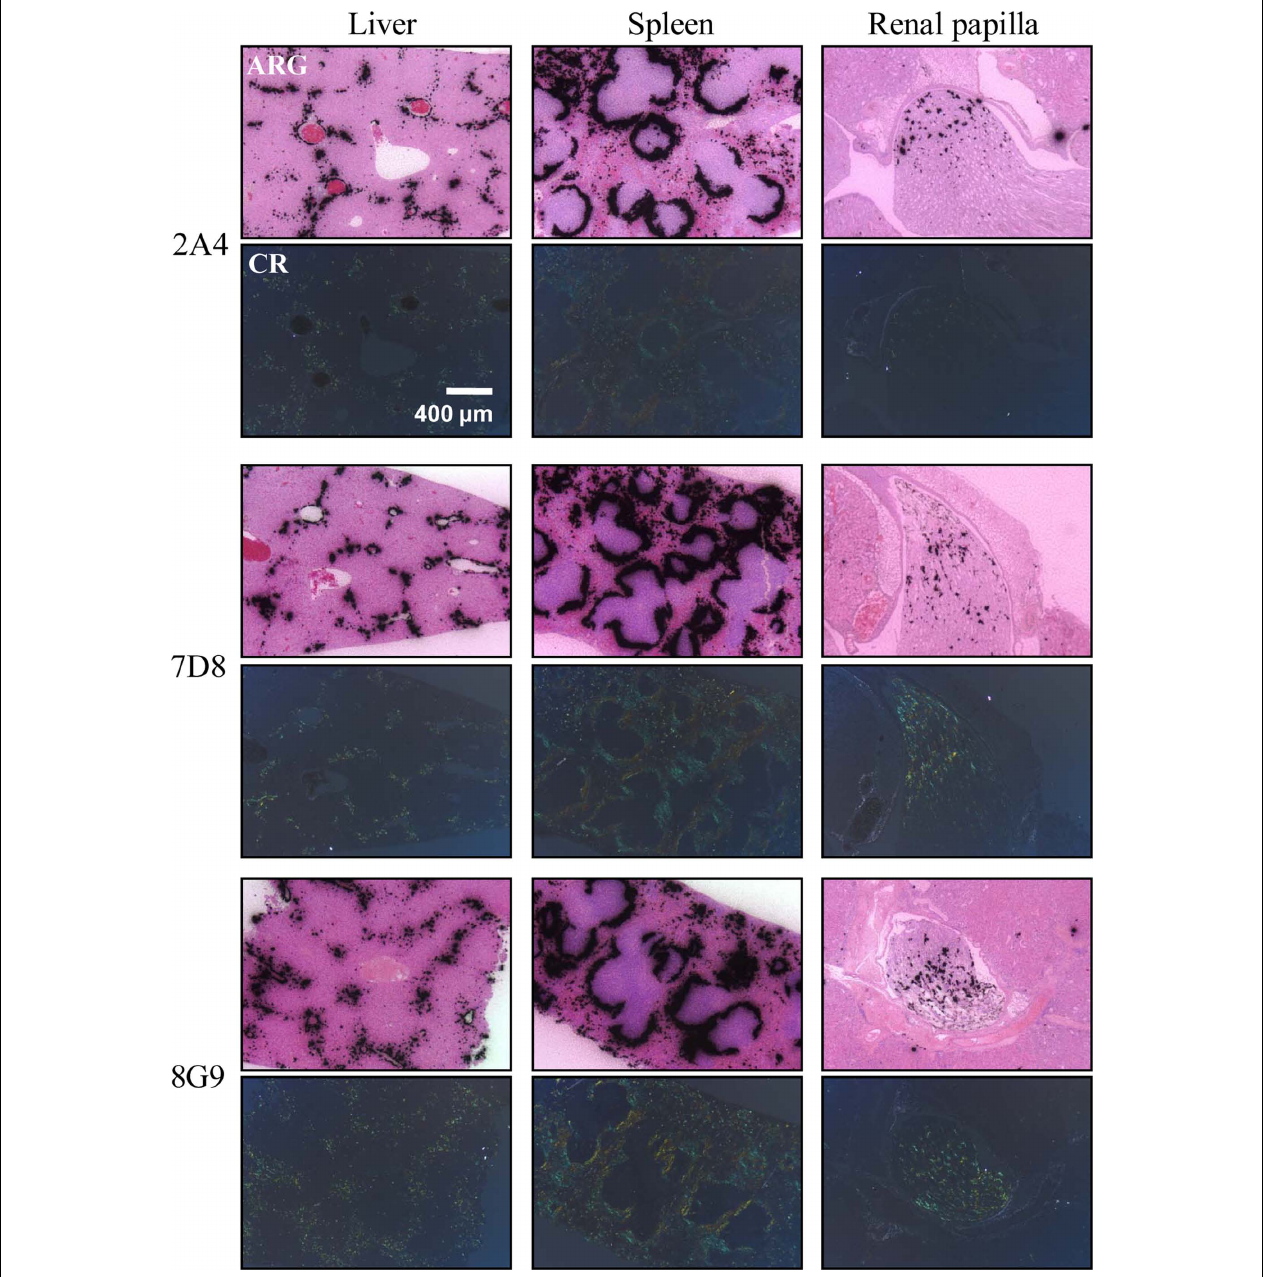
FIGURE 7 | Specific in vivo binding of radiolabeledAA fibril-specific mAbs toAA amyloid. Comparison of Congo red (CR)-stained tissue sections with autoradiographs (ARG) of murine AA deposits in liver, spleen, and renal papilla from H2-L d -huIL-6 mice given i.v. injections of 125 I-labeled mAbs 2A4, 7D8, or 8G9.